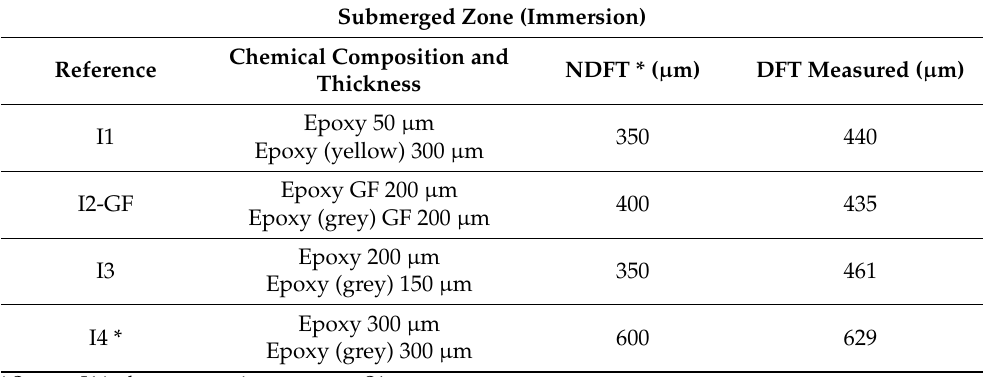
Table 6. Selected coating systems for the submerged